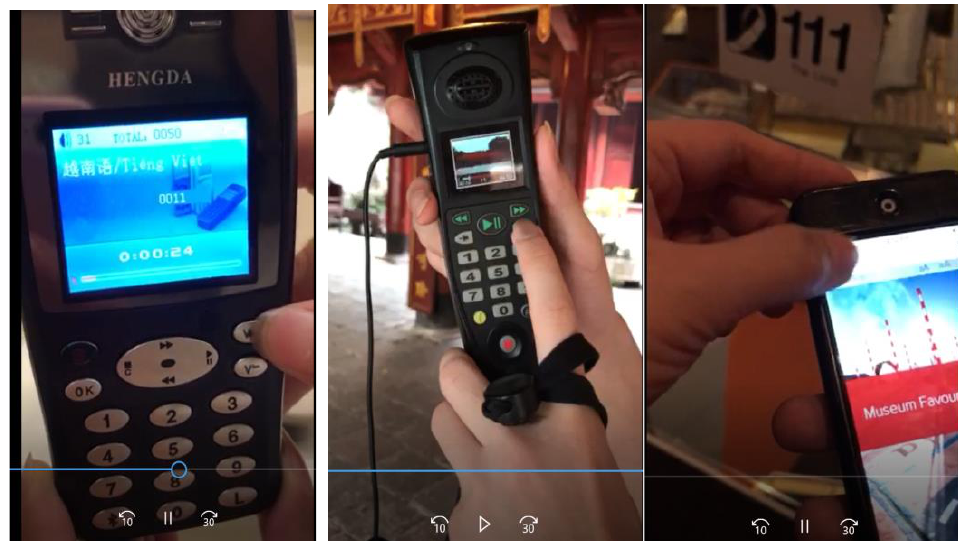
Figure 2. The video snapshots from the videos about audio guides’ operation from VNMH ( left ), TL, NMA ( right ).